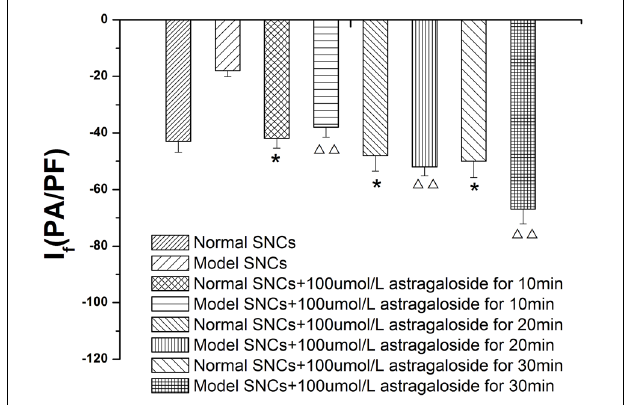
FIGURE 5 | Time dependence of the effects of astragaloside on the peak current density of the I f in normal SAN cells. n = 10, ∗ P < 0.05 vs. the normal group. (cid:49)(cid:49) P < 0.01 vs. SAN cells after establishment of the model.